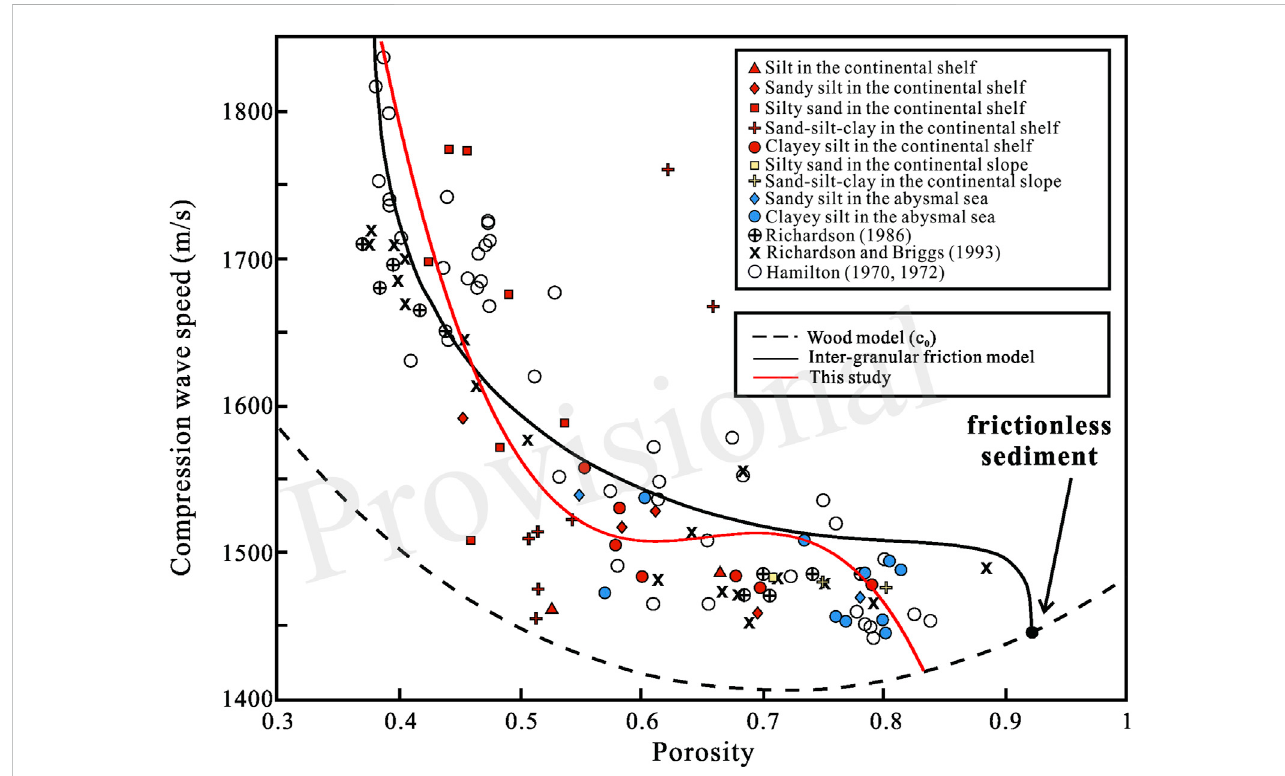
Relationship between the porosity and compression wave speed of sea fl oor